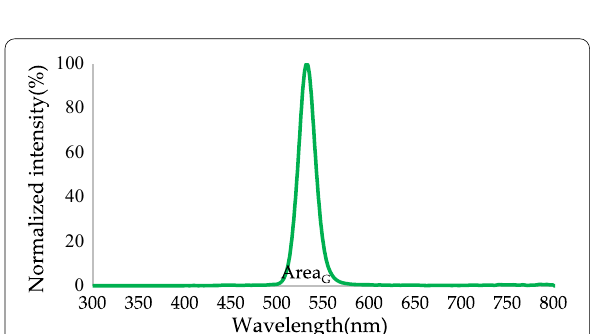
than the light conversion efficiency that was observed when the RCPEF was not used. At this point, the color purity could be increased to 97.49%. The data for the blue-to-green light conversion are shown in Fig. 11. Figure 11a shows the color of the emit- ted light without RCPEF. Because most of the emitted light was in the incident blue wavelength band, the color of the emitted light was the color mixed by the green quantum mixing incident wavelength, which led to a color shift that was similar to cyan. The addition of the RCPEF changed the color of the emitted light (Fig. 11b). The part of the incident wavelength that the QDs could not absorb was reflected by the RCPEF back to the QDs layer for reabsorption and re-excitation, and it was then radiated as green light to obtain purer green light. At this point, the color purity could be increased to 97.49%. RCPEF for Red QDs Blue micro-LEDs were converted into red light through red QDs. The data for the conversion of normalized blue light to the red light spectrum are shown in Fig. 12. The peak of red light was 633.5 nm, and the FWHM was 41.5 nm. Most of the emitted light was incident light blue,